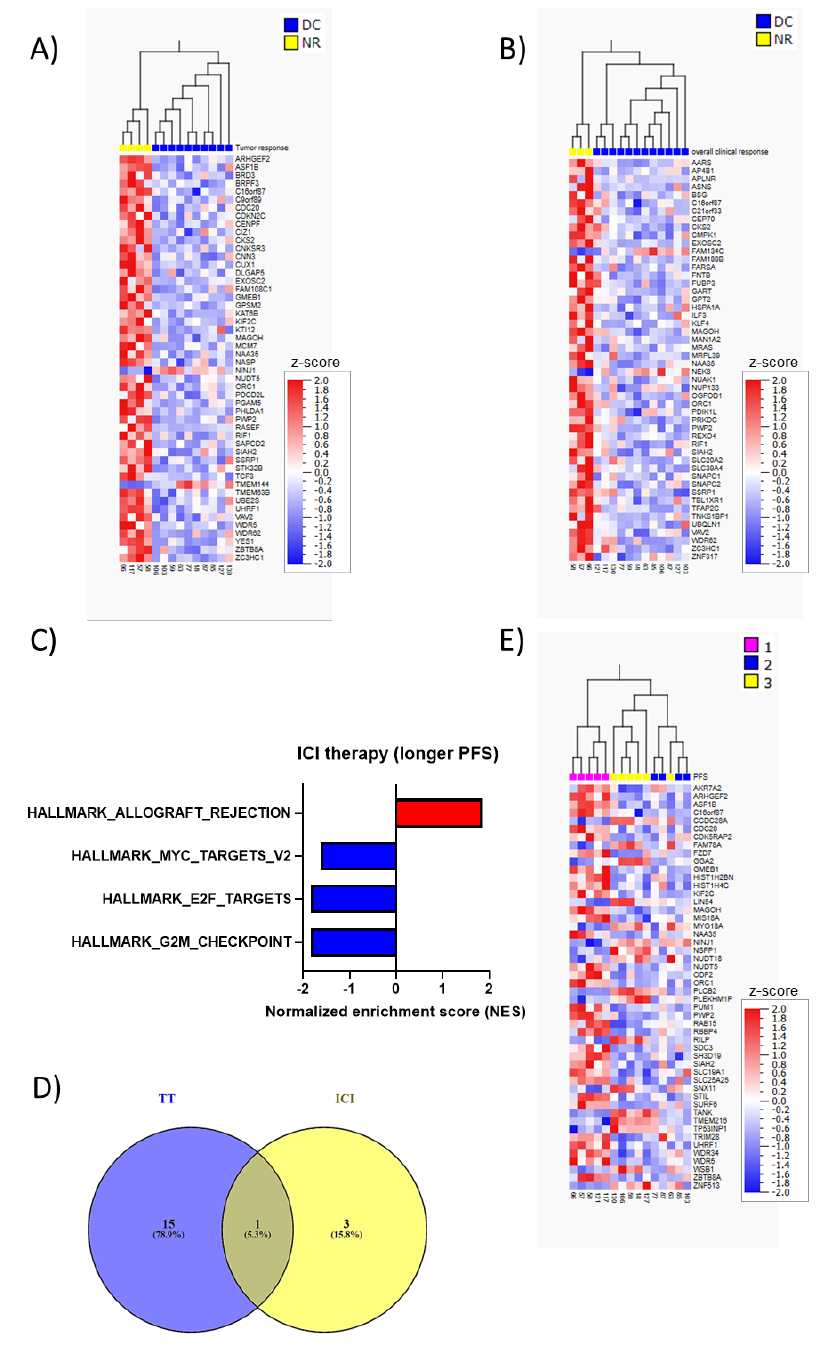
Figure 3. Low proliferative and high allograft rejection signatures are associated with longer PFS in patients treated with ICI. ( A , B ): Heatmaps for hierarchal clustering of the top 50 differentially expressed genes between DC and NR (tumor-specific and overall response, respectively) to ICI treatment. ( C ): GSEA shows enriched gene sets in relation to PFS when divided into 3 groups: PFS < 6 months, PFS > 6 months and ≤ 2 years, and PFS > 2 years PFS after ICI therapy. ( D ): Venn diagram showing the overlap between enriched gene sets (FDR < 20%) in relation to PFS in the TT and ICI cohort. ( E ): Heatmap for hierarchal clustering of the top 50 differentially expressed genes in relation to PFS to ICI treatment when divided into three groups (PFS < 6 months, PFS between 6 months and 2 years, and PFS > 2